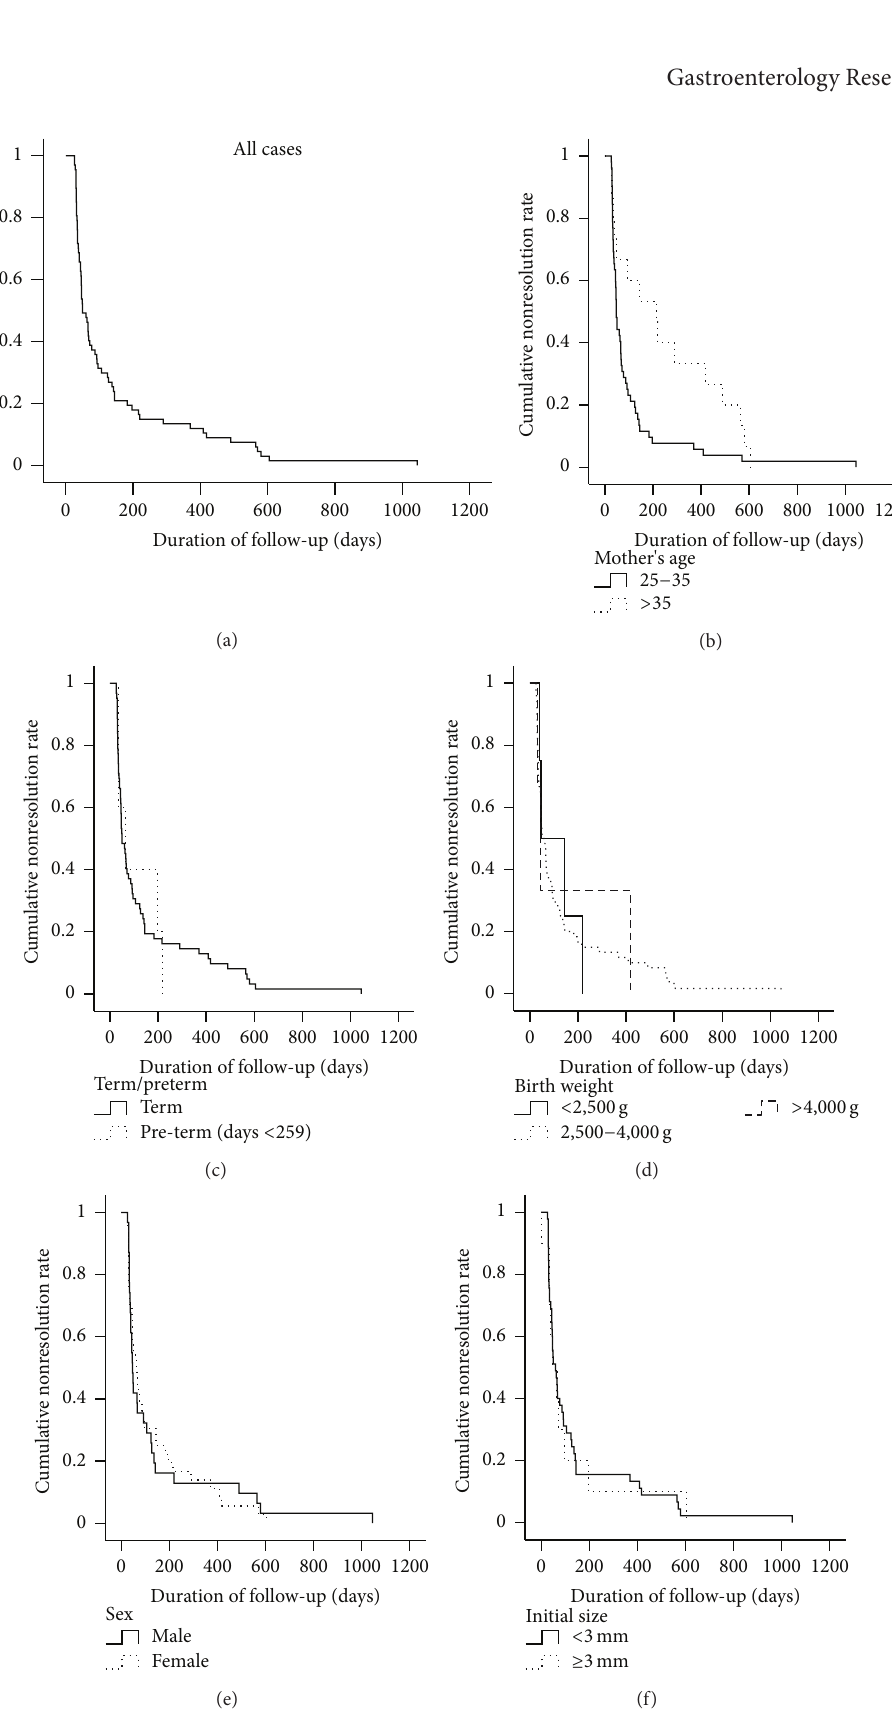
Figure 3: Kaplan-Meier survival curves for nonresolution rate, by log-rank test. (a) All cases. (b) Compared by mother’s age ( 𝑃 = 0.013 ). (c) Compared by term and preterm status ( 𝑃 = 0.998 ). (d) Compared by birth weight ( 𝑃 = 0.988 ). (e) Compared by sex ( 𝑃 = 0.953 ). (f) Compared by initial CBD size ( 𝑃 = 0.466